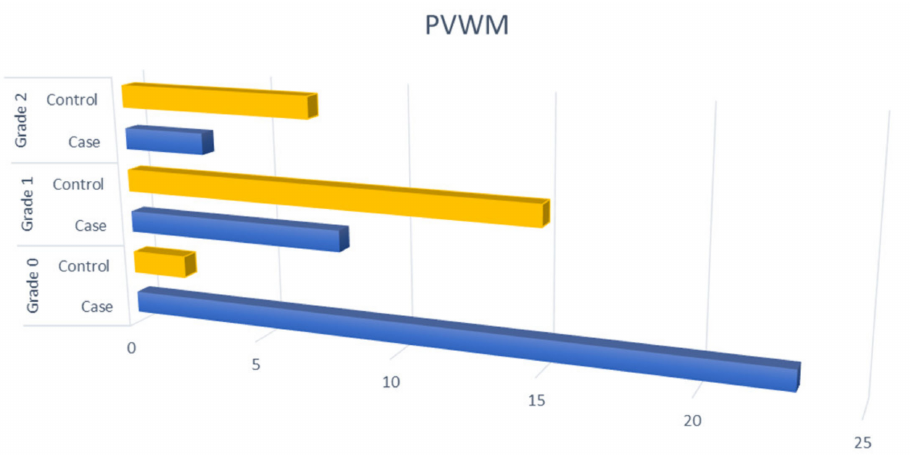
Figure 3. Comparison of patients with OSAHS and control group with respect to SVD in the PVWM.